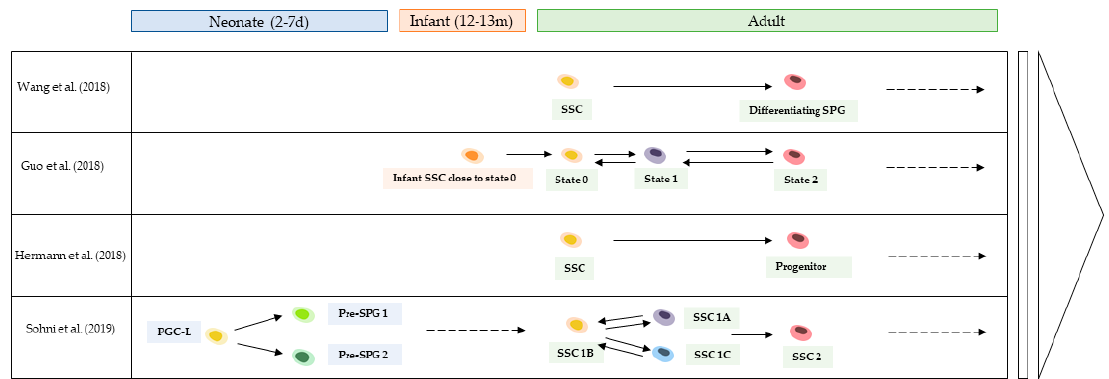
Figure 2. Timeline of hSSC development from birth to adulthood, summarizing the results from the different scRNAseq analyses on human postnatal SSC [12,19,21,23]. Days (d), Human spermatogonial stem cell (hSSC), Months (m), Primordial germ cells like (PGC-L), Single-cell RNA sequencing (scRNAseq), Spermatogonia (SPG), Spermatogonial stem cell (SSC).